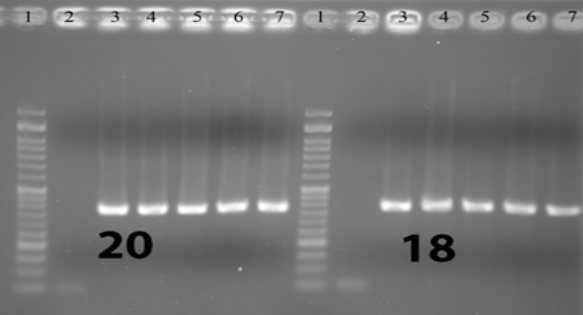
Figure 4 . Visualized product on electrophoresis gel for nested PCR of exons 19 and 21 1, 2, 3, 4, 5, 6, 7: Patients 8: Negative control 9: Ladder